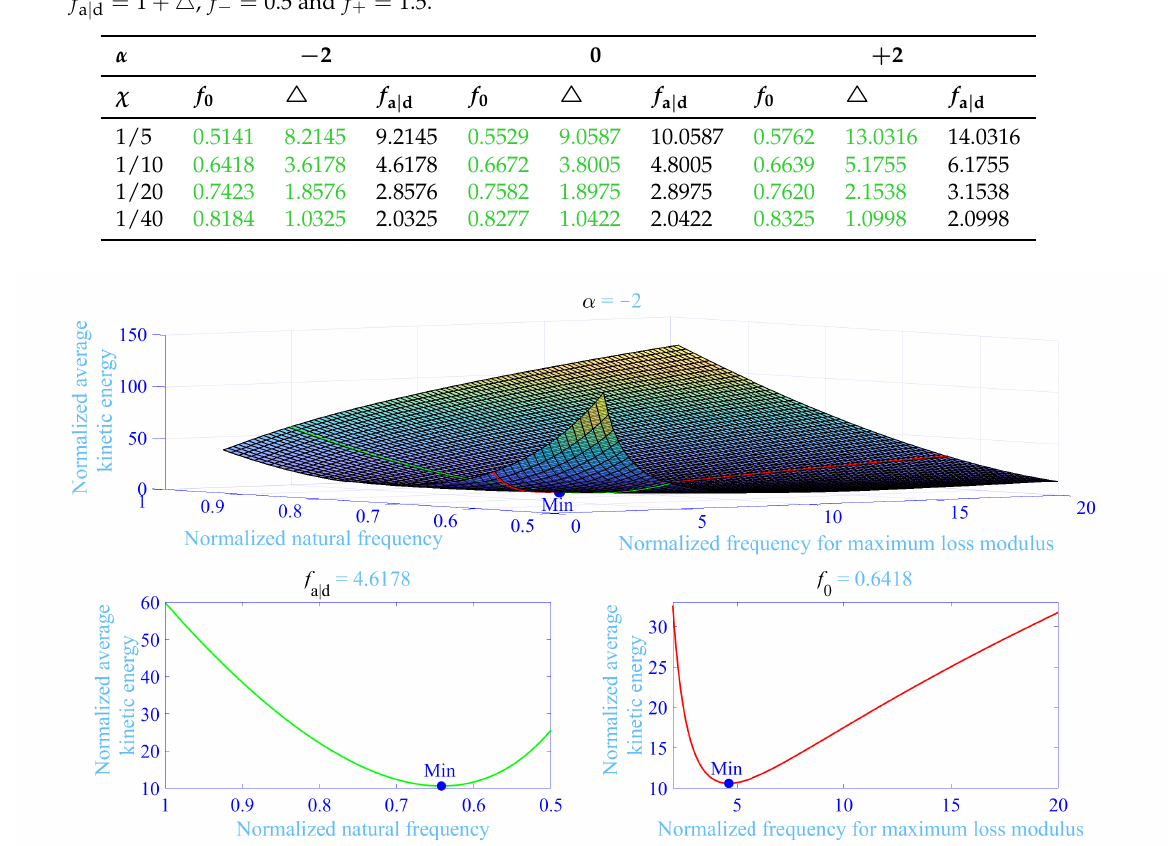
Table 2. Optimized hydrogel dynamic vibration damping properties in green at C = 0.04 with